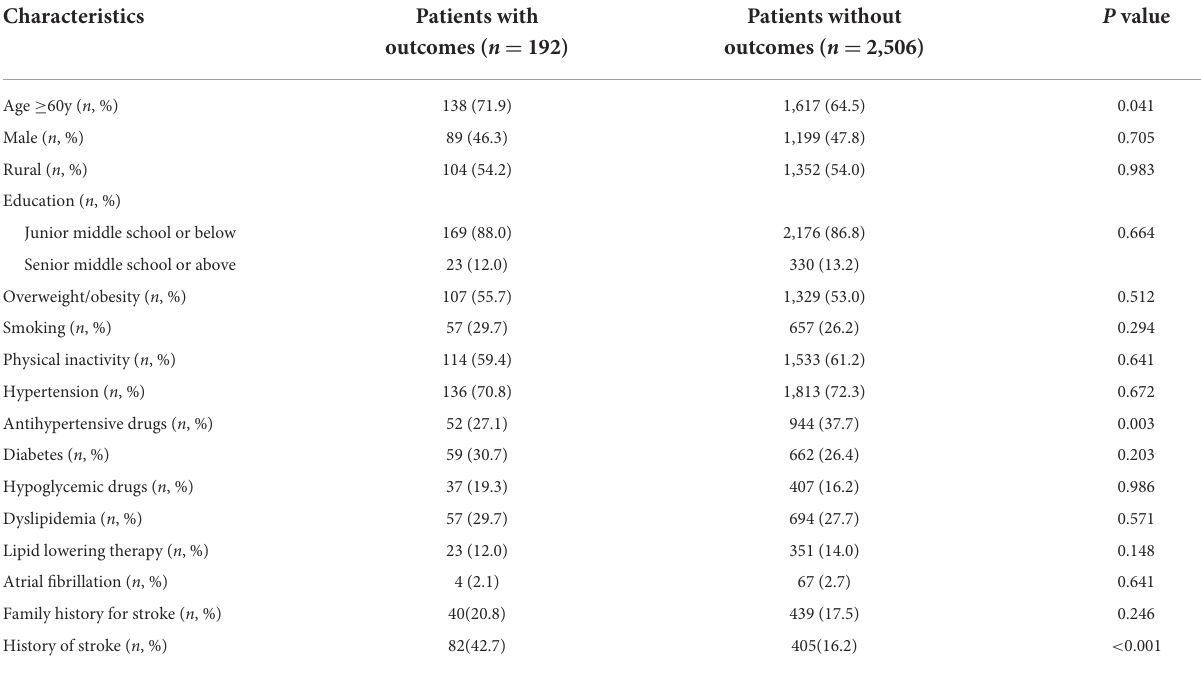
TABLE 3 Comparison of patients with and without outcomes during follow-up periods.